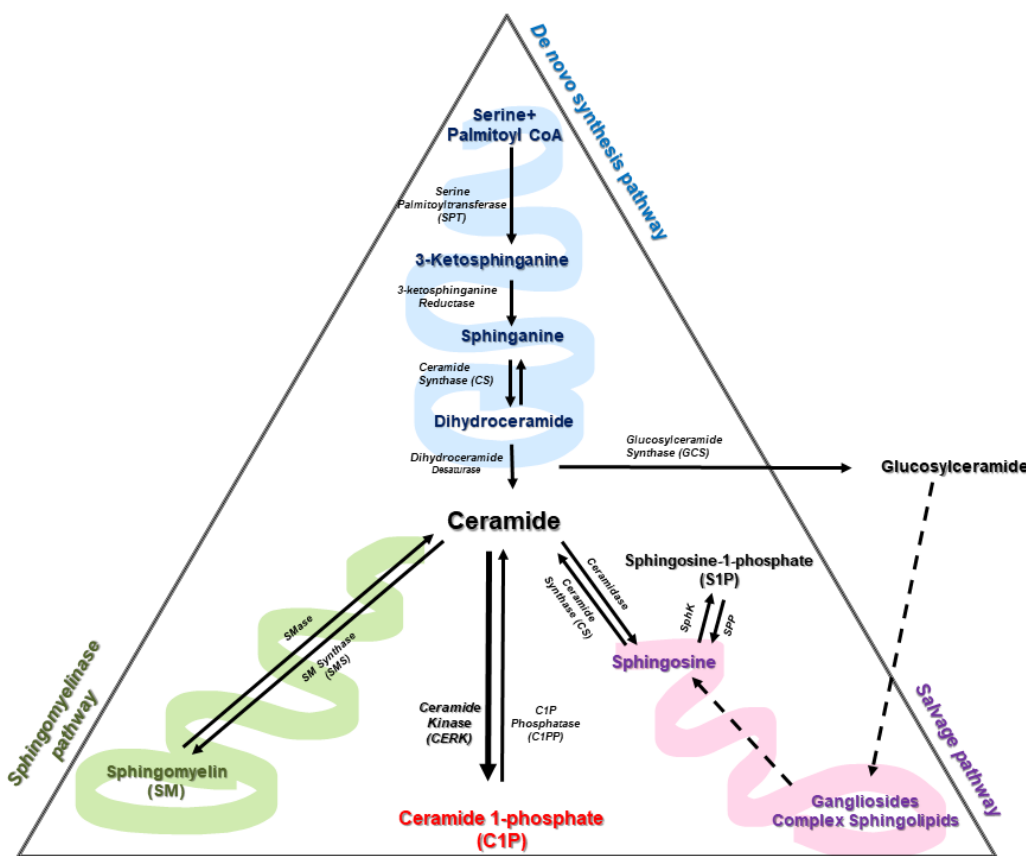
Figure 2. Representation of sphingolipid metabolism with ceramide as the central metabolite. SphK = sphingosine kinase; SPP = sphingosine-1-phosphate phosphatase and SMase = sphingomyelinase.